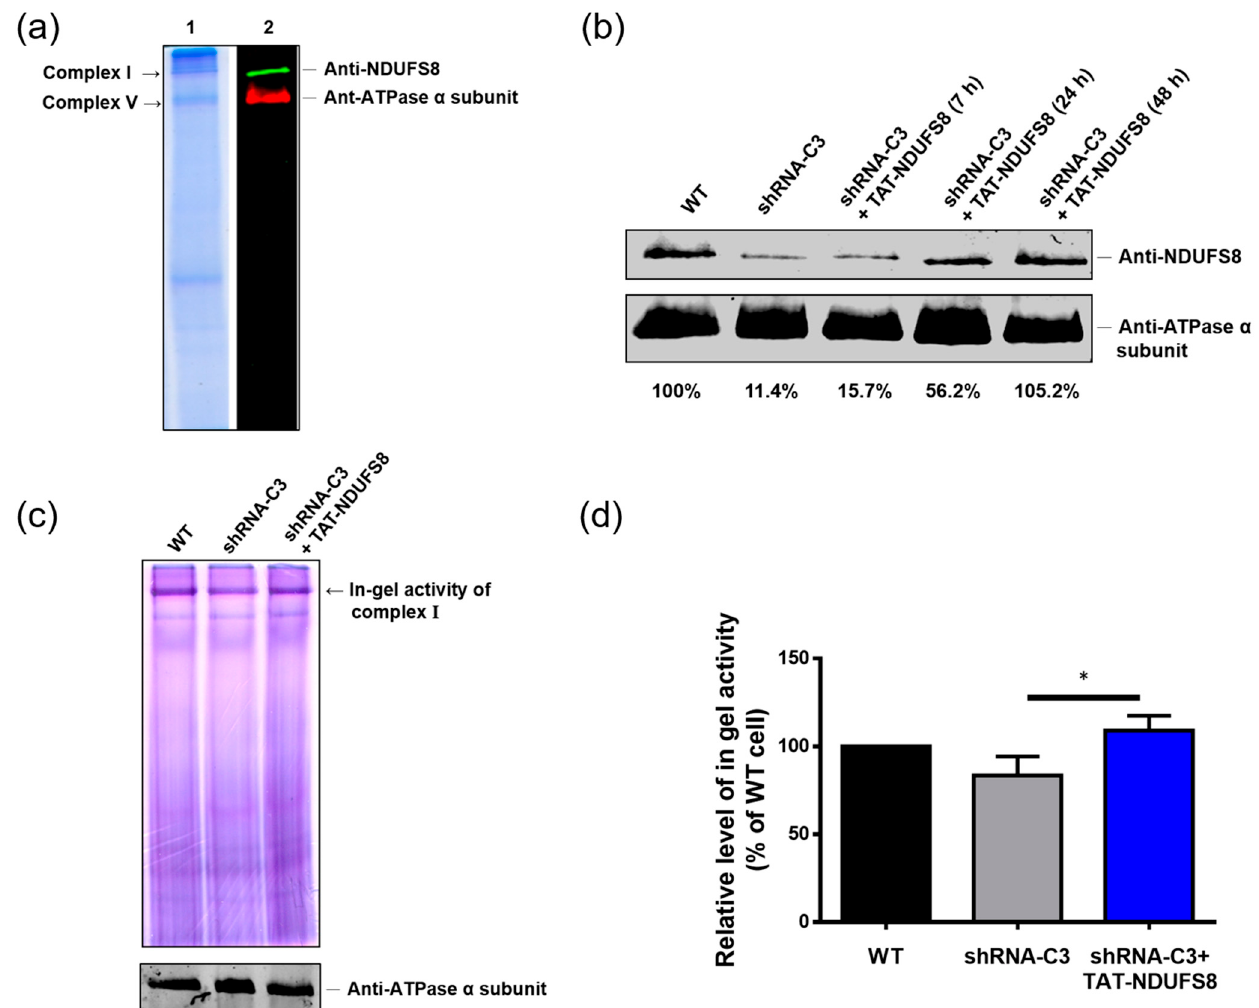
Figure 6. Protein transduction of exogenously produced TAT-NDUFS8 improved the assembly of mitochondrial complex I and restored the complex I in-gel activity in shRNA-C3 cells. ( a ) The protein profile of mitochondria-enriched samples derived from wild-type T-REx-293 cells. Mitochondrial membrane protein complexes solubilized by DDM from T-REx-293 cells were separated by HrCNE, and the protein profile and the location of protein complexes of the extract were visualized by Coomassie blue staining and immunoblotting analysis, respectively. ( b ) The effect of TAT-NDUFS8 treatment on the status of complex I assembly in shRNA-C3 cells. After protein transduction with 0.03 mg/mL TAT-NDUFS8 for different periods of time as indicated and subcellular fractionation, the obtained mitochondria were solubilized with DDM, resolved by HrCNE, and immunostained with anti-NDUFS8 antibody. Staining of ATPase α subunit in complex V was used as the loading control. ( c ) The effect of TAT-NDUFS8 treatment on complex I in-gel activity in shRNA-C3 cells. The obtained gel from HrCNE was incubated with NADH and NBT to perform in-gel activity staining. The amount of ATPase α subunit in complex V was detected by anti-ATPase α subunit antibody and used as a loading control. ( d ) The in-gel activity of complex I was estimated by ImageJ software, normalized to the amount of ATPase α subunit, and is shown as a percentage relative to that of T-REx-293 cells ( n = 3; * p <